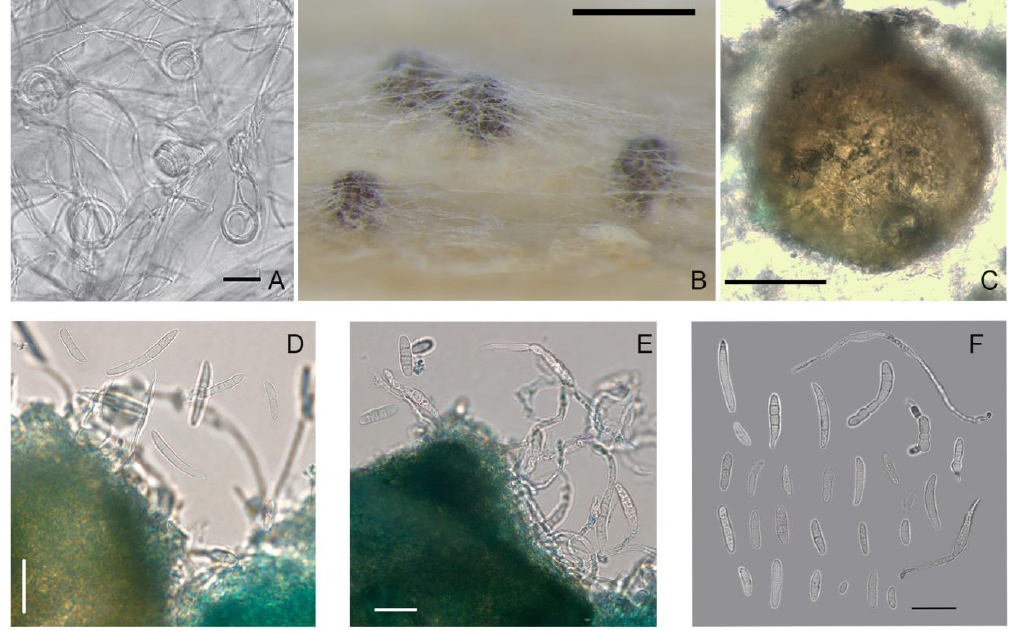
Figure 7. M. seminicola strain MFG 60138: ( A ) the coils in hyphae; ( B , C ) ascomata on wheat stems; ( D ) conidia; ( E ) germinated ascospores that exuded from perithecium; and ( F ) variety of formed spores, some of them germinated. Media: ( A ) PSA; (B–F) wheat stems. Scale bars: ( A , D – F ) 20 µ m; ( B ) 200 µ m; ( C ) 50 µ m.